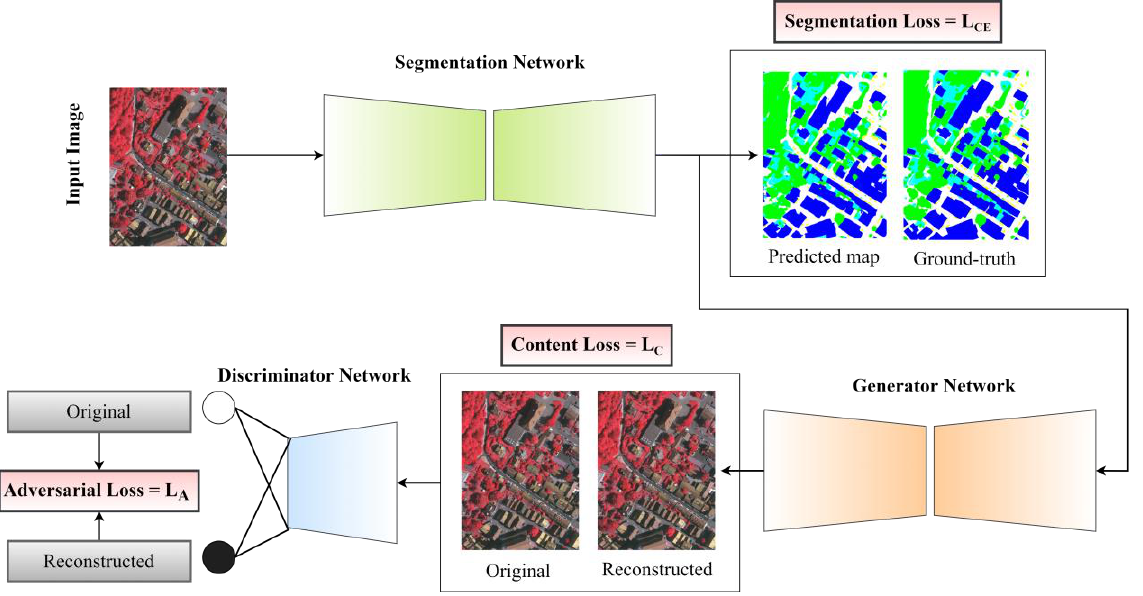
Figure 1 . Illustration of the proposed semantic segmentation network.